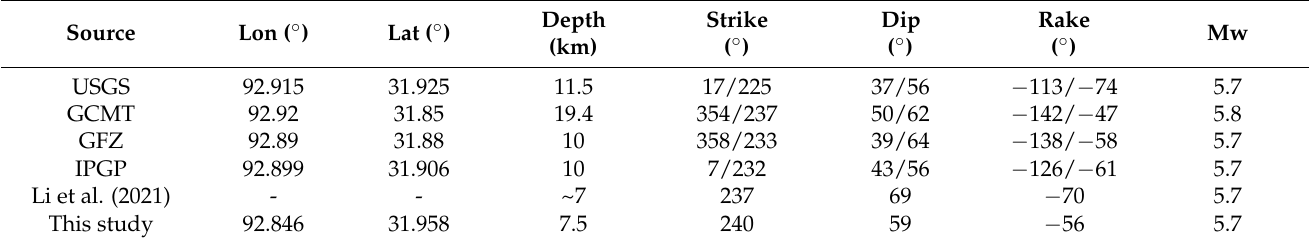
Table 1. Source parameters for the 2021 Nagqu earthquake.